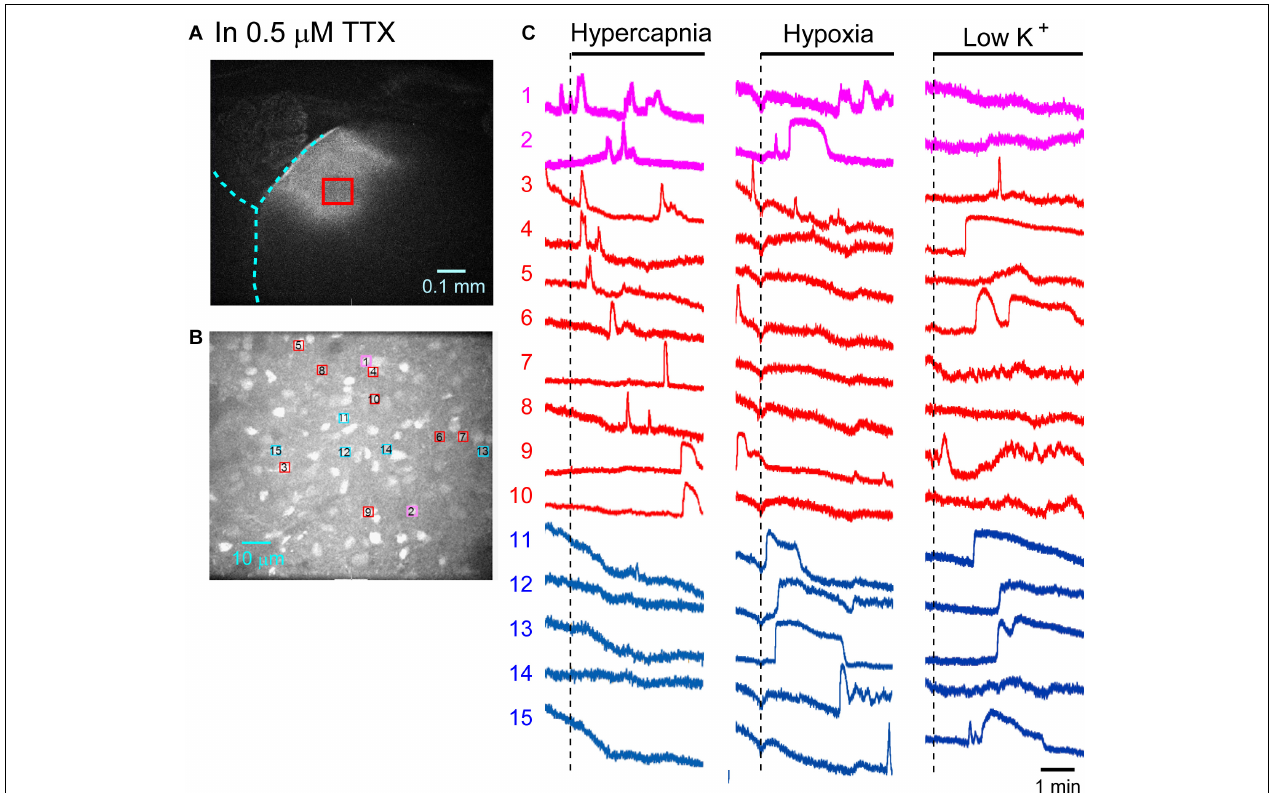
FIGURE 4 | Calcium imaging in the NTS in TTX solution. (A) Low-magnification image of the cut surface where Oregon Green was injected and calcium imaging was performed. (B) Optical image of the cut surface stained with Oregon Green. The red square in (A) corresponds to the measured area in (B) . (C) Calcium signals plotted as fluorescence intensity in identified NTS cells numbered in the image in (B) in response to hypercapnia (left), hypoxia (middle) and low K + (right) stimulation. Magenta traces denote calcium signal intensity of cells (Nos. 1 and 2) responding to stimulation of both hypercapnia and hypoxia. Red traces denote calcium signal intensity of cells (Nos. 3–10) responding only to hypercapnia. Blue traces denote calcium signal intensity of cells (Nos. 11–15) responding only to